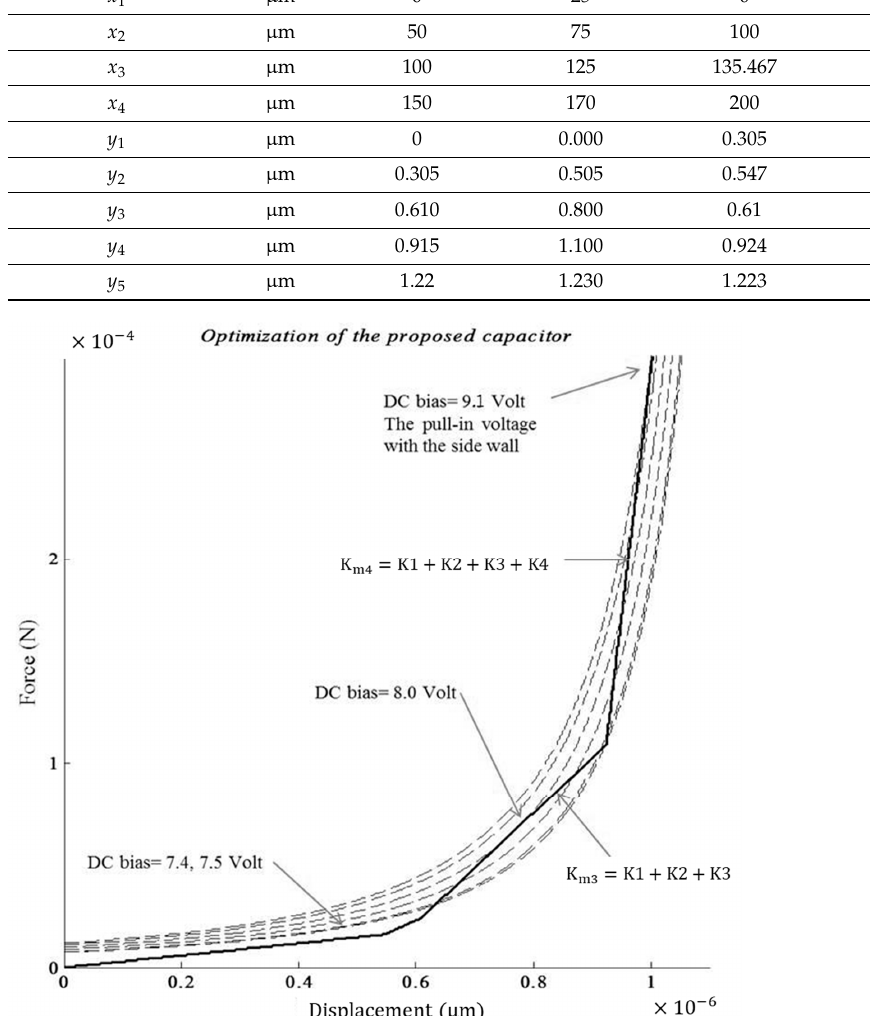
Figure 5. The electric force and mechanical force graph in accordance with the optimization value. We confirmed that the displacement value according to the voltage (7.4 V~pull-in point). Table 3 shows the equilibrium points in accordance with electrical force and me- chanical force nodes. Table 3. Displacement value according to voltage.